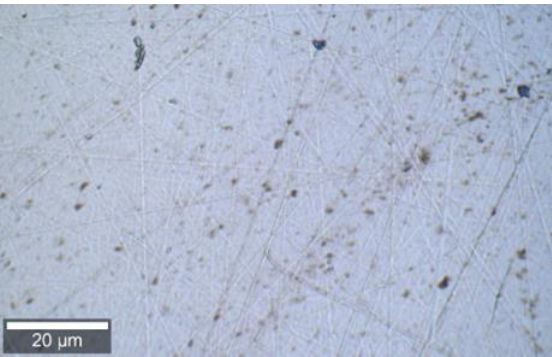
Figure 1. Surface pits and scratches caused by particle agglomeration on a wafer surface.